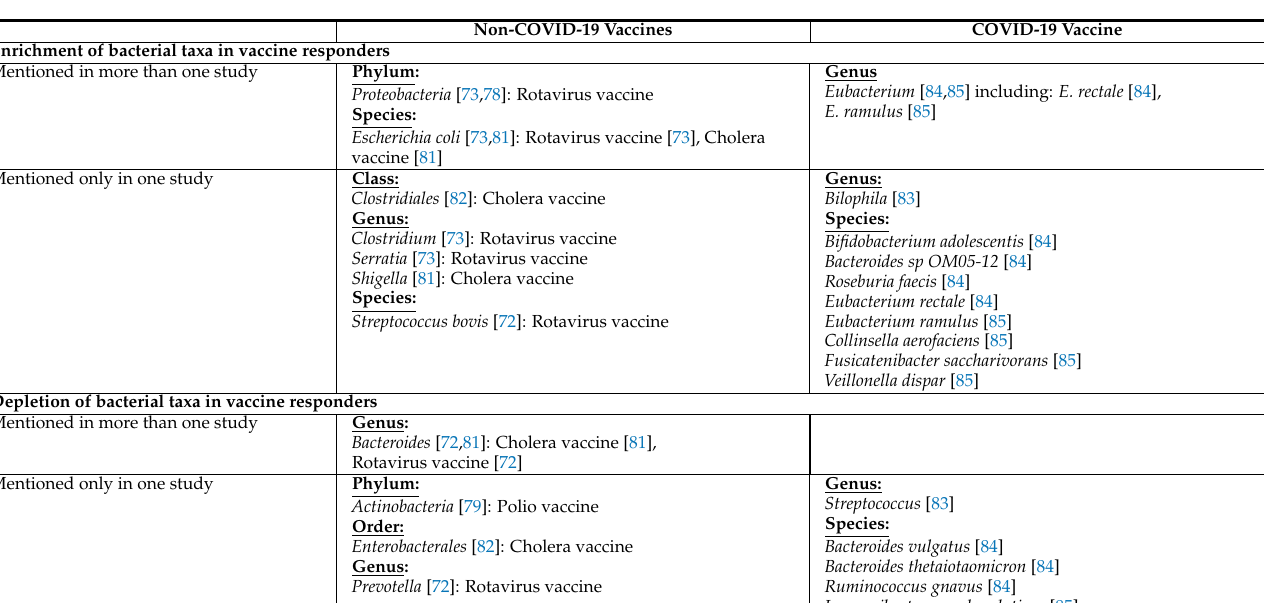
Table A2. Enrichment and depletion of bacterial taxa in non-COVID-19 and COVID-19 vaccine responders with frequency of reports in current